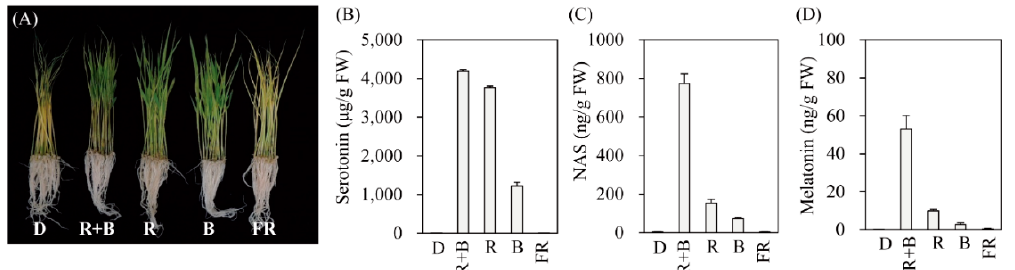
Figure 1. Effects of various light wavelengths on serotonin, N -acetylserotonin, and melatonin production in rice seedlings. ( A ) Phenotypes, ( B ) serotonin, ( C ) N -acetylserotonin, and ( D ) melatonin levels in response to cadmium treatment under various light conditions. Seven-day-old rice seedlings were rhizosperically challenged with 0.5 mM CdCl 2 for 3 days under continuous light wavelength condition. D, dark; R + B, combined red and blue LED light (7:3 ratio); R, red LED light; B, blue LED light; FR, far-red LED light. Light intensity in R + B, R, and B was equal to 60 μ mol × m − 2 × s − 1 whereas FR was 4 μ mol × m − 2 × s − 1 . Values are means ± standard deviations of three independent experiments. FW, fresh weight.